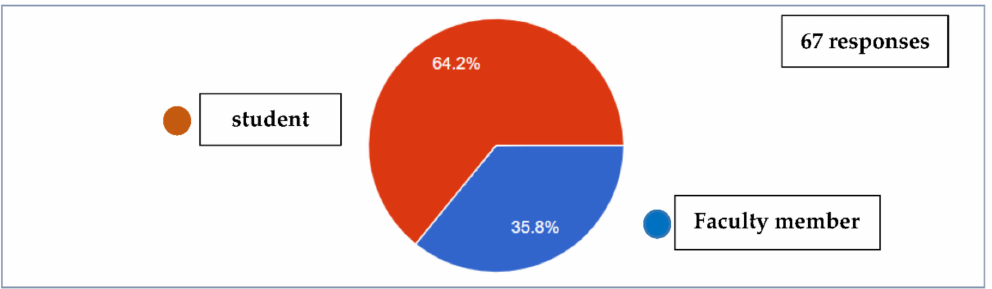
Figure 25. The distribution of the sample between the responses of faculty members and